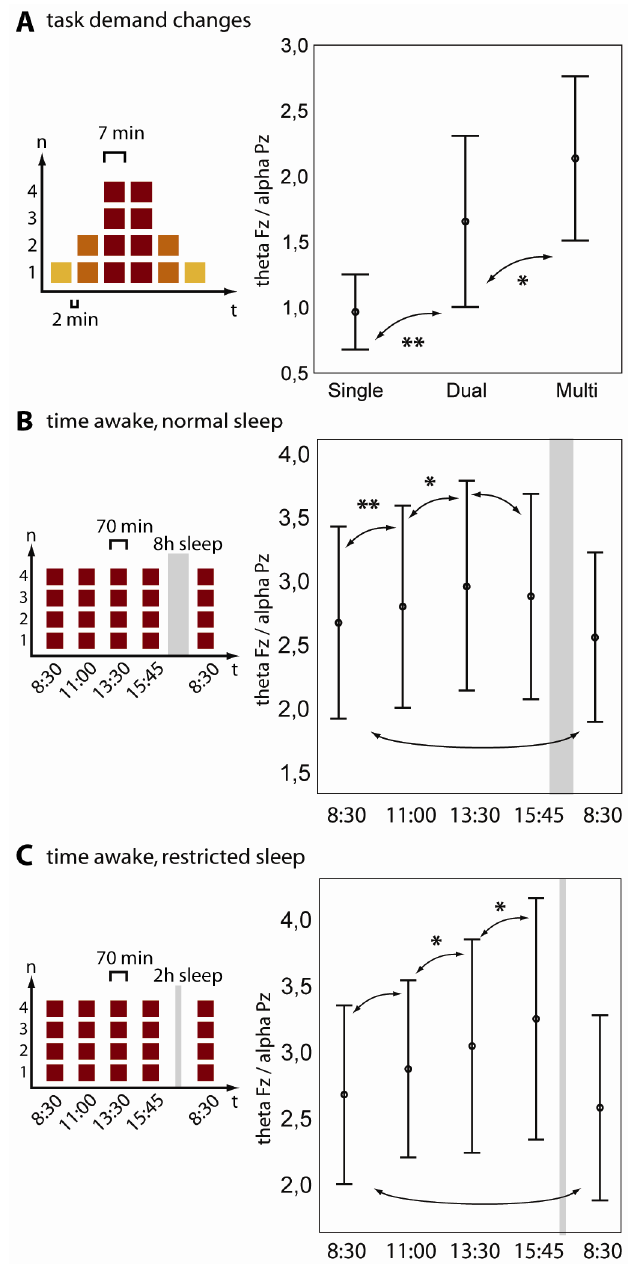
FIGURE 3. Theta Fz/alpha Pz correlates with external and internal factors. (A) The theta Fz/alpha Pz ratio increased systematically with increasing task demands (F[1.3, 25.0] = 8.6, p = 0.004, n = 20; single vs. dual, p = 0.002; dual vs. multi, p = 0.014). (B) Normal sleep protocol. The theta Fz/alpha Pz ratio increased with time awake (F[2.4, 35.6] = 7.1, p = 0.002, n = 16; 8:30 vs. 11:30, p = 0.009; 11:30 vs. 13:30, p = 0.029; 13:30 vs. 15:45, p = 0.168). After a well-slept night, the ratio returned to the baseline value, p = 0.139, even though the performance was improved. (C) Sleep restriction protocol. The theta Fz/alpha Pz ratio increased with time awake (F[2.3, 34.0] = 6.2, p = 0.004, n = 16; 8:30 vs. 11:00, p = 0.096; 11:00 vs. 13:30, p = 0.027; 13:30 vs. 15:45, p = 0.017). After a well-slept night, the ratio returned to the baseline value, p = 0.477. Error bars indicate